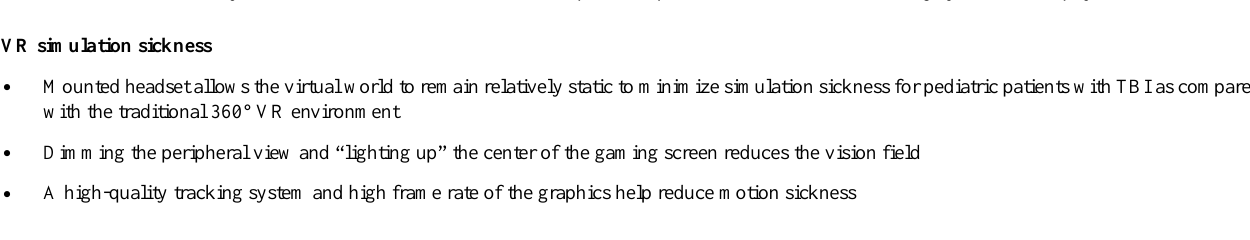
Textbox 1. Design considerations for virtual reality applications used for traumatic brain injury rehabilitation. Headset burden on the injured